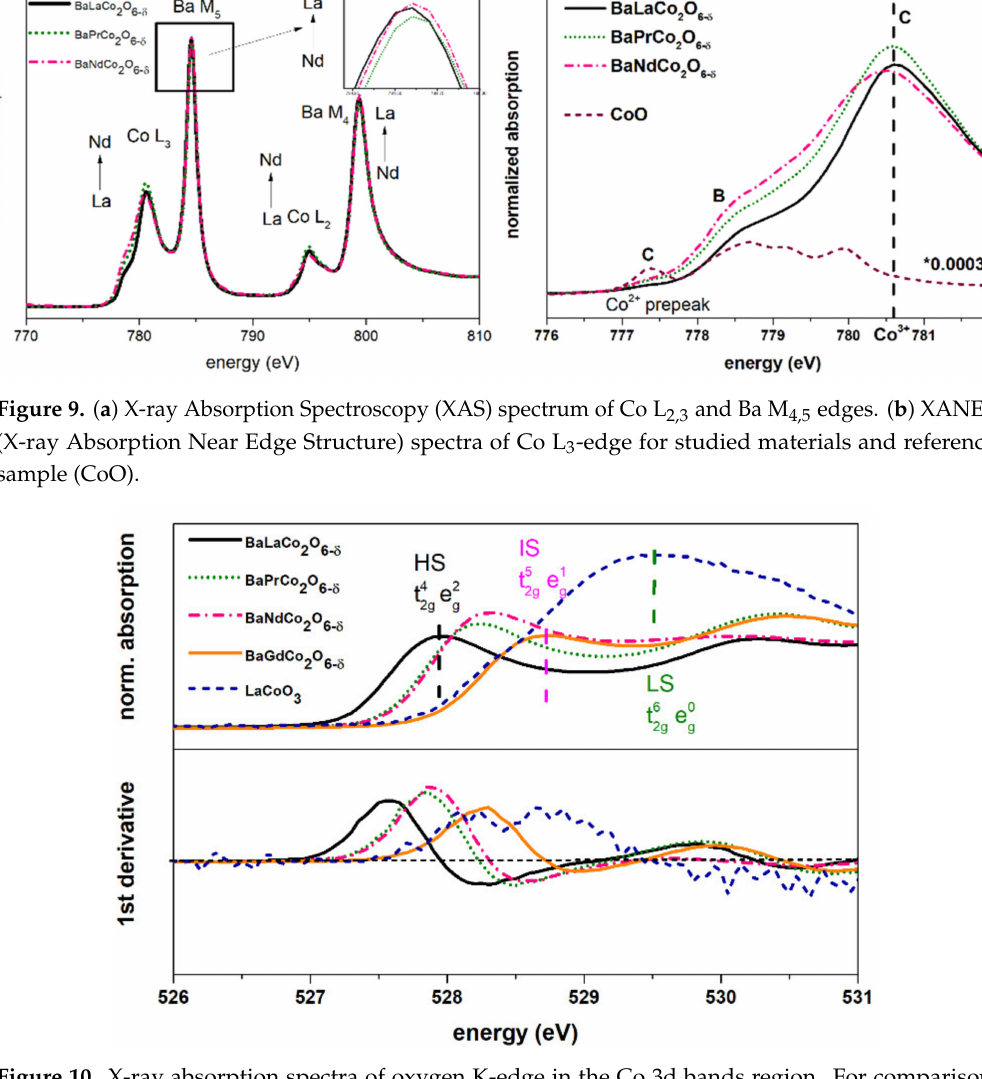
Figure 10. X-ray absorption spectra of oxygen K-edge in the Co 3d bands region. For comparison, intermediate spin (BaGdCo 2 O 6 ) and low spin (LaCoO 3 ) reference samples are